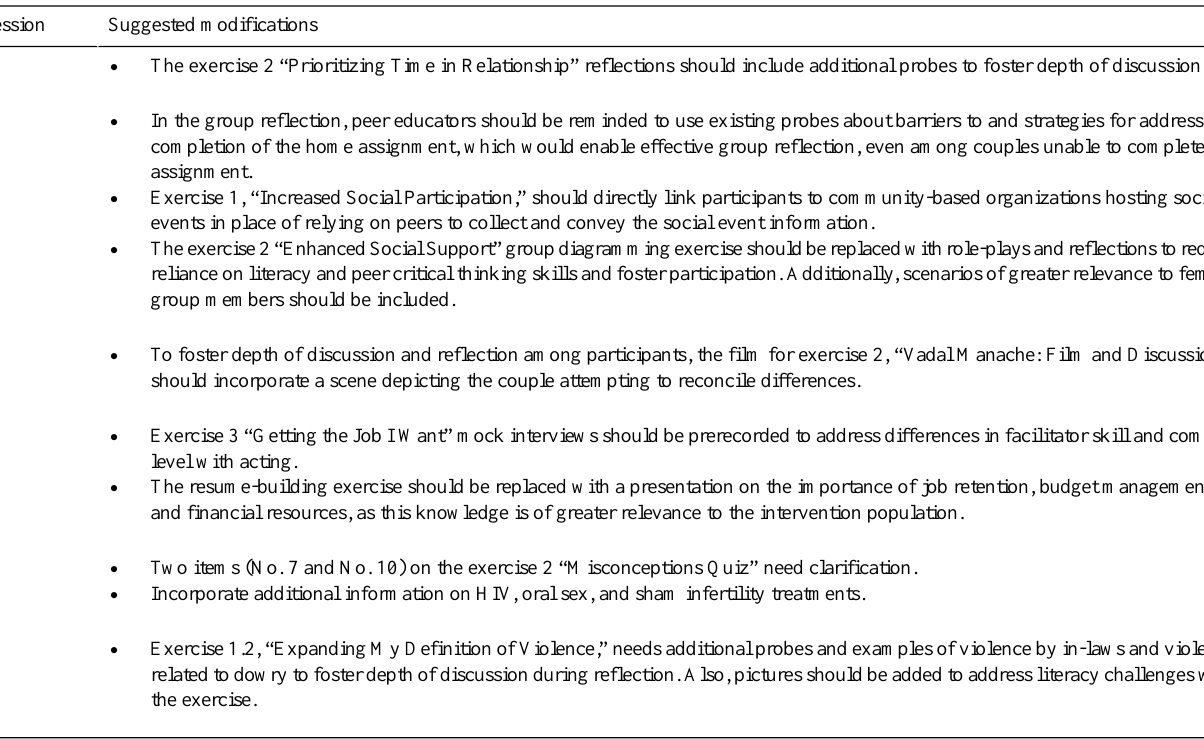
Table 2. Suggested session modifications to enhance acceptance and feasibility of Ghya Bharari Ekatra intervention delivery. Suggested